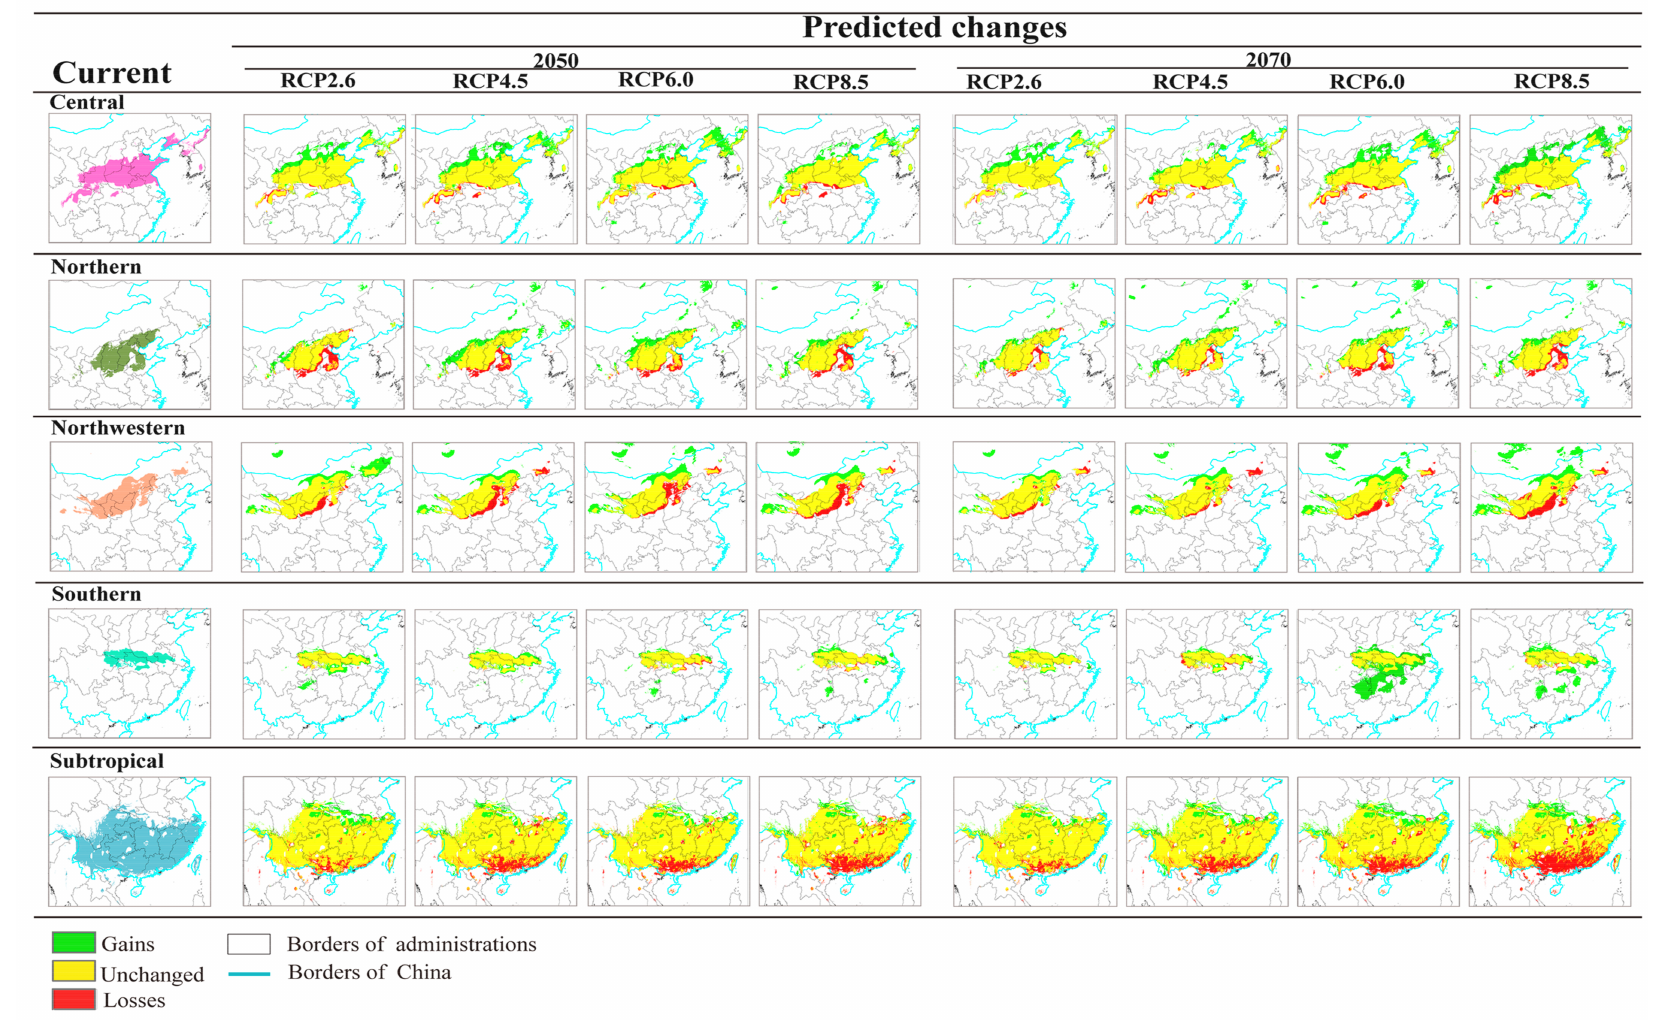
Figure 3. Projected changes in suitable habitat for each of the five seed zones (rows) under different climate scenarios/years